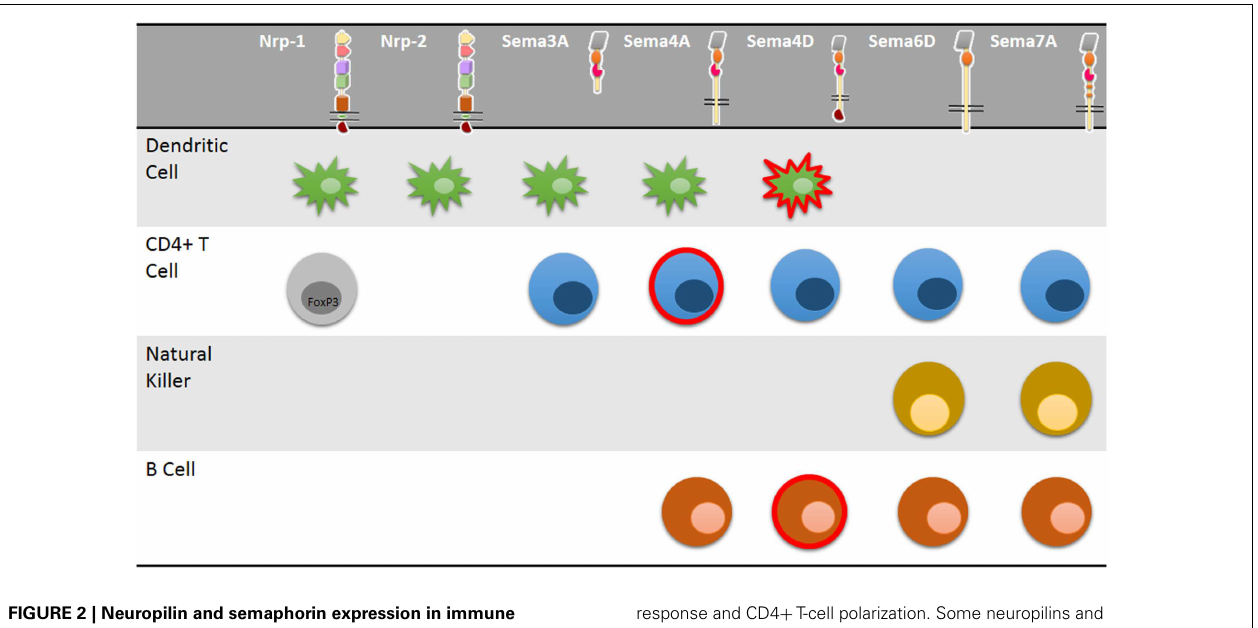
FIGURE 2 | Neuropilin and semaphorin expression in immune cells . Multiple immune cells express neuropilins and semaphorins and signaling through these molecules control distinct cellular properties including cell migration, activation, or modulation of immune cell